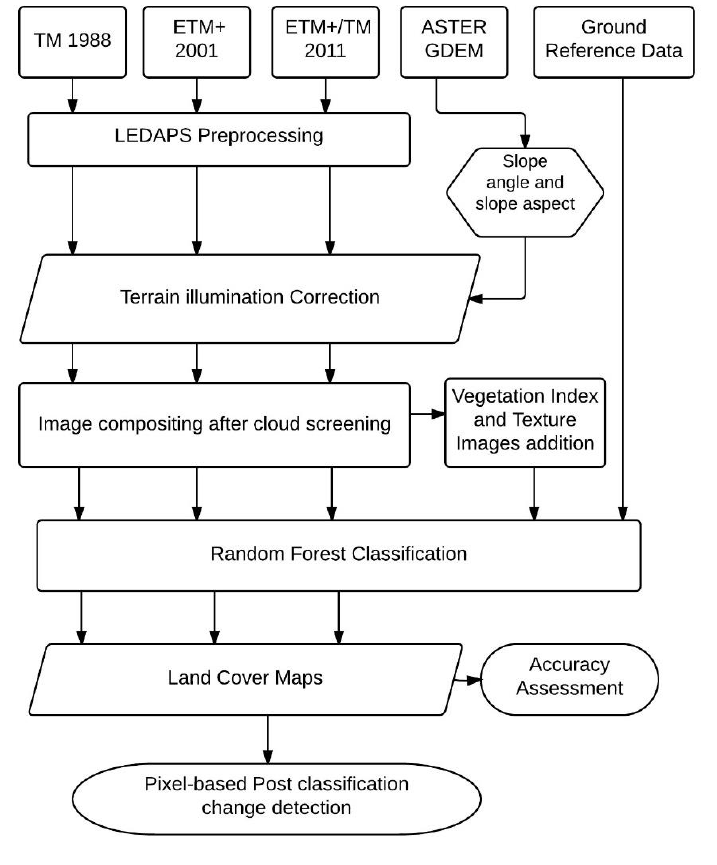
Figure 3. Flowchart for the procedures performed in the